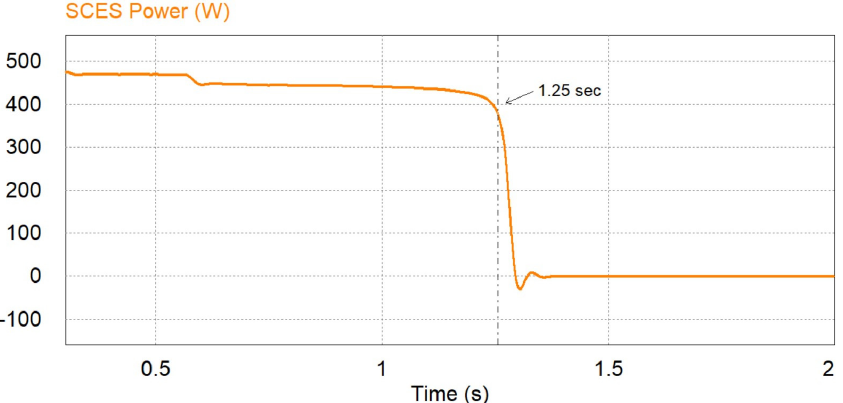
Figure 19. The SCES power—Case 3.